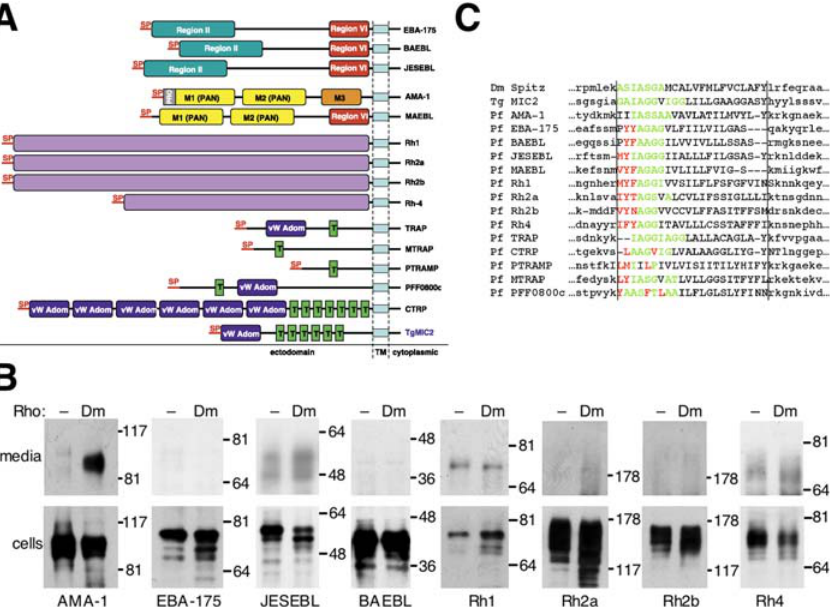
Figure 1. P. falciparum Transmembrane Adhesins Involved in Host-Cell Invasion (A) A generalized schematic of the 14 Plasmodium adhesins analyzed in this study. Sizes of the molecules are meant to represent their relative sizes but are not to scale (N-termini are leftmost). Indicated domains are SP, signal peptide; TM, transmembrane domain; vW Adom, vonWillebrand A domain; T, thrombospondin; and Pro, prodomain. The Toxoplasma MIC2 adhesin is shown for comparison. (B) Sequence of Plasmodium adhesin transmembrane domains (in capital letters) compared to those of Drosophila Spitz and Toxoplasma MIC2, with the putative membrane boundaries depicted as two vertical lines. Residues conducive for rhomboid cleavage are shown in green, while those that interfere with cleavage are in red. (C) Cleavage of GFP-tagged Plasmodium adhesins by DmRho-1 (Dm) was examined in transiently transfected COS cells by anti-GFP Western analysis of media fractions. Cleaved adhesins are rapidly secreted into the cell culture media, while the cell fractions are shown as controls. Molecular weight standards in kDa are denoted to the right of each panel. DOI: 10.1371/journal.ppat.0020113.g001 PLoS Pathogens |